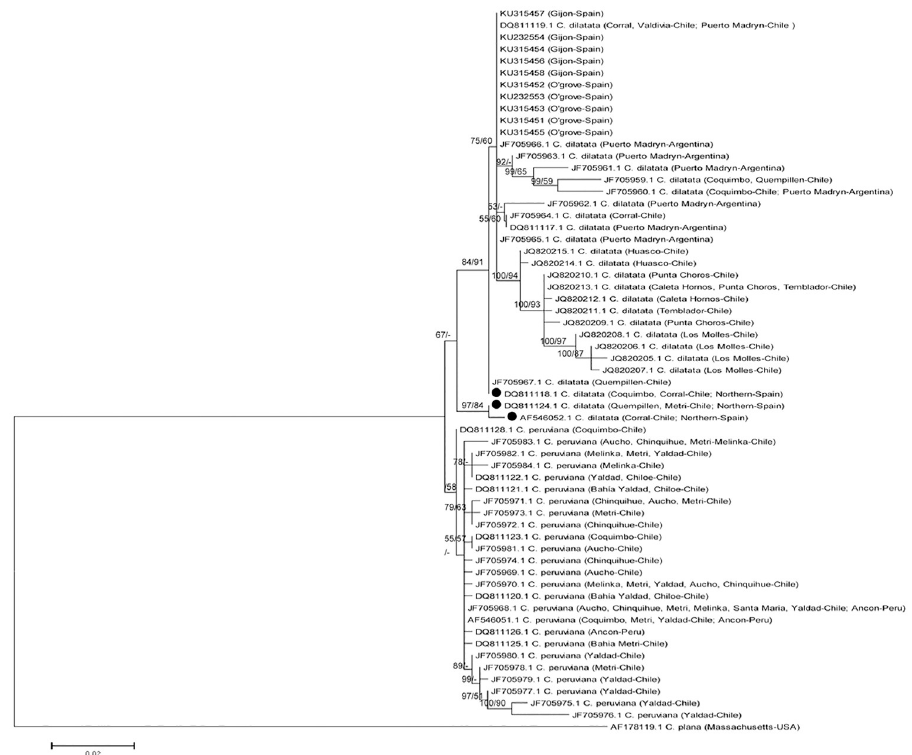
Fig 11. Bayesian consensus tree obtained from the analysis of the COI gene. Sampling location and the GenBank accession number are given for each sequence when available. Values above the nodes indicate a posteriori probabilities and bootstrap support for the MP and ML analyses,